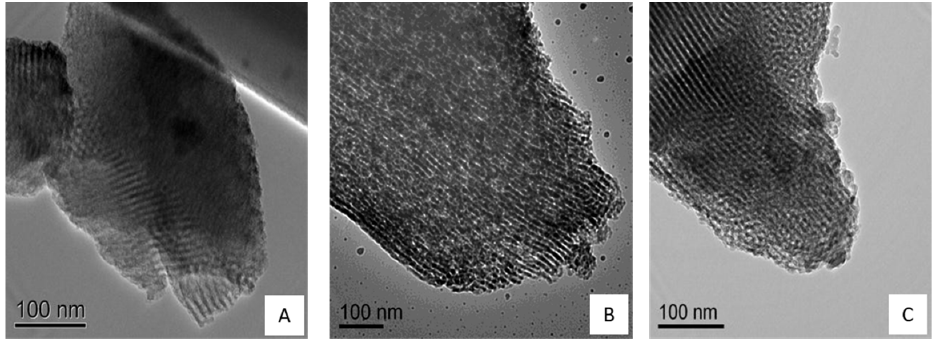
Figure 5. TEM images of mesoporous silica nanoparticles SBA-15 ( A ), SBA-15/HAP_1 ( B ) and SBA-15/HAP_2 ( C ).